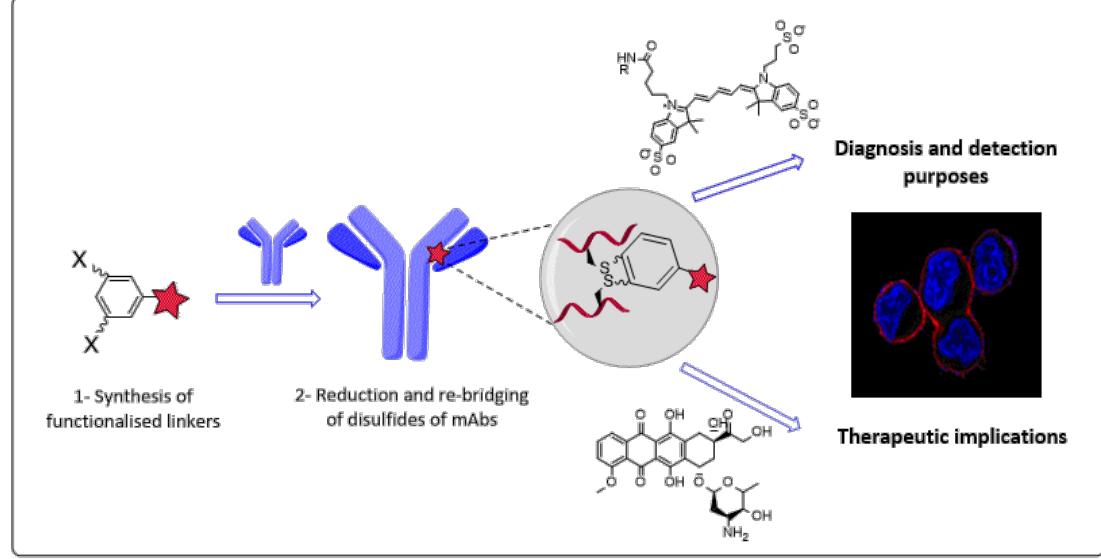
Figure 13. Our approach to obtain labelled conjugates of antibodies.